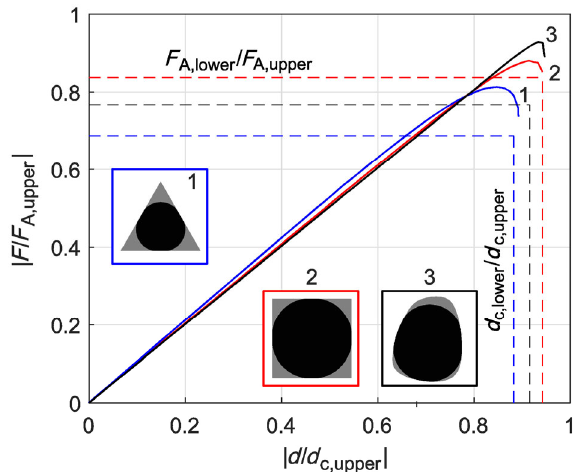
Fig. 4 Force-distance dependencies for simply connected convex profiles: triangle, square, an “arbitrary” shape. The very rough picture in this case is similar to that of a circular cylinder: the normal force first increases linearly with the distance between bodies and then drops sharply. However, the transition from the linear increase to the complete detachment now takes some (small) interval of detachment distances. The state corresponding to the incircle of the corresponding shape is shown with dashed lines.